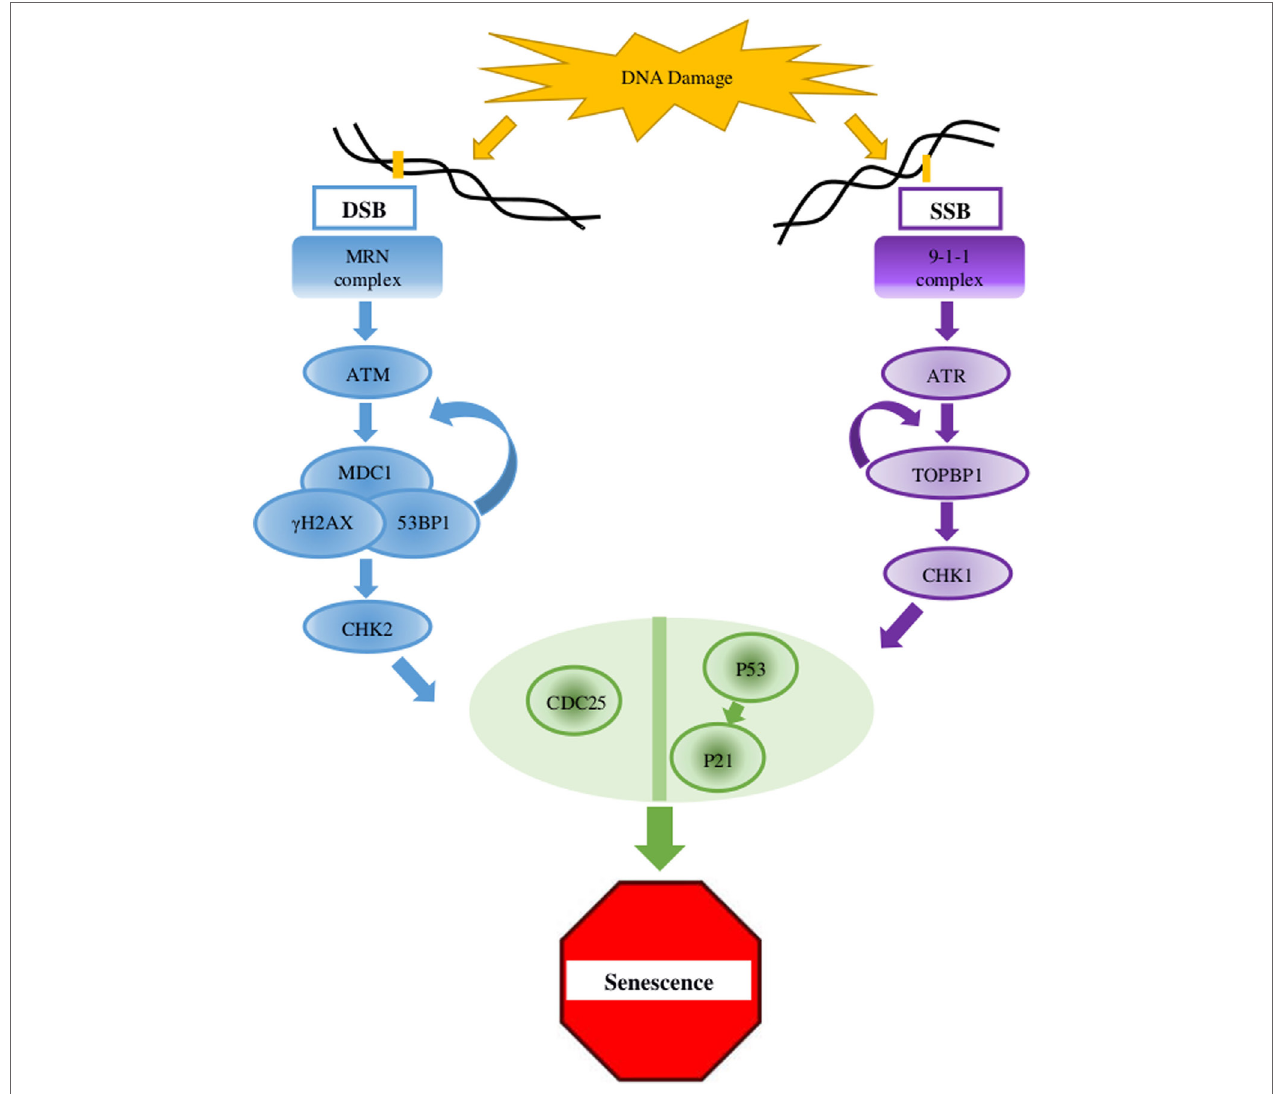
FiGURe 1 | Key elements in the DNA damage response (DDR) pathway. In case of double-strand breaks (DSB), the DNA damage sensor MRN complex recruits the protein kinase ATM which activates γ H2AX at the damaged site. γ H2AX connects to MDC1, and this complex amplifies the activity of the MRN complex which, in a positive feedback, amplifies the ATM activity and the dispersal of γ H2AX along the chromosome. MDC1 and 53BP1 further mediates the activation of CHK2 which carries the signal to distant locations on the genome. For single-strand breaks (SSB), the protein kinase ATR is activated and amplified by the 9-1-1 complex and TOPBP1, which also mediates the activation of CHK1. The signaling pathway cascades toward the key factors p53 and CDC25. When the lesion is repaired, the DDR complexes are dismantled (2, 4,